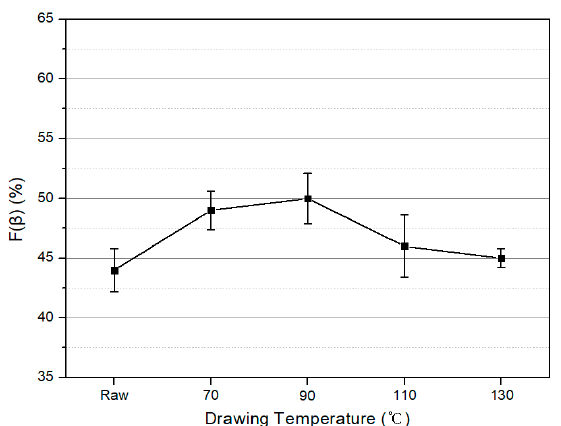
Figure 9. Relative intensity of the β crystalline phase in the PVDF/PAR composites with drawing temperature (Unpoled).